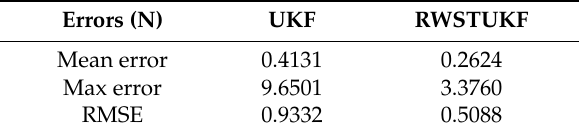
Figure 6. Reconstructed forces via both UKF and RWSTUKF for robotic indentation. Table 4. Estimation errors of both UKF and RWSTUKF for robotic indentation.